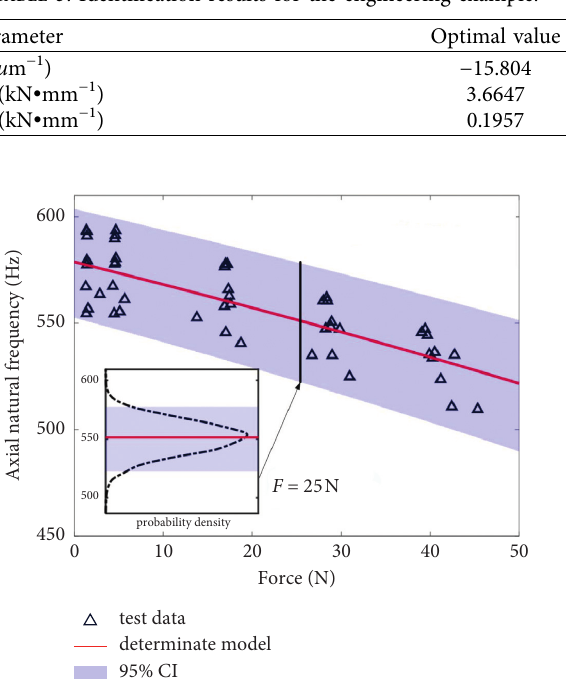
Figure 20: Prediction of the frequency with nonlinearity and